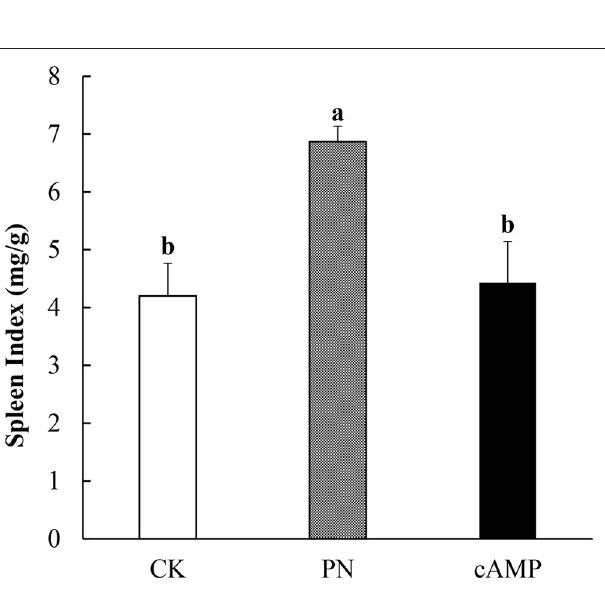
FIGURE 5 | Effect of oral administration with cAMP on spleen index in PN-sensitized mice. Data are expressed as the means ± SDs. Different lowercase letters represent mean significant difference ( p < 0.05) between the groups of